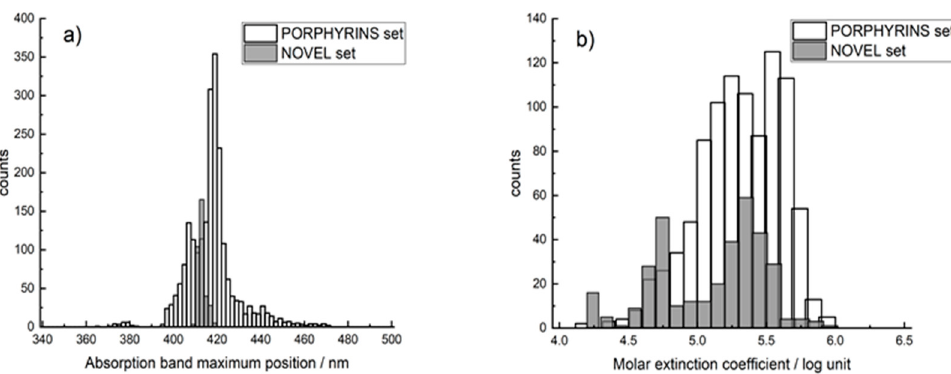
Figure 2. Histogram of the distribution of PORPHYRINS and a NOVEL set of 335 porphyrins synthesized in our laboratory by absorption wavelengths ( a ) and the value of the extinction coefficient ( b ).